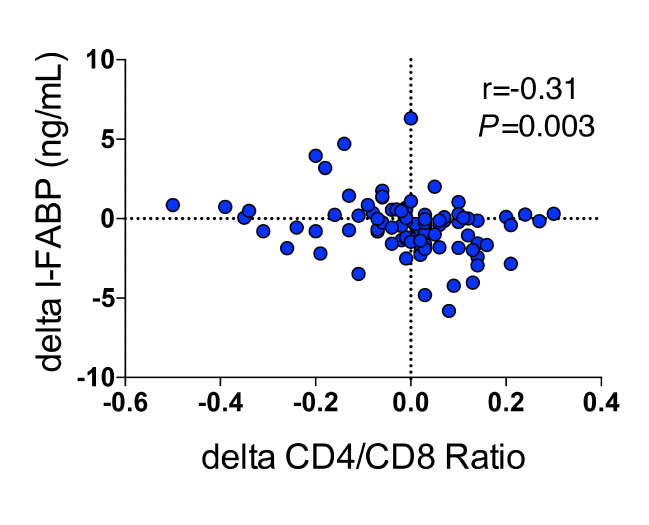
Figure 3. Association of changes in I-FABP with changes in CD4/CD8 T-cell